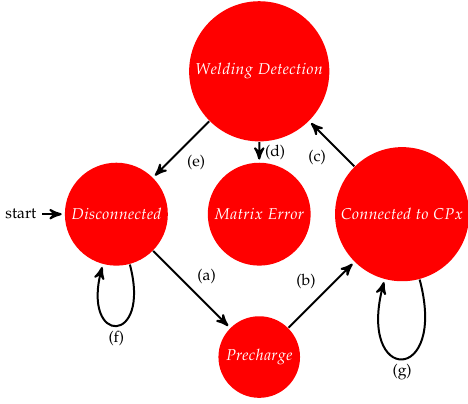
Figure 5. The Switching Matrix State Machine. (a) Relay Turn on Request, (b) Relay Turn on, (c) Relay Turn off Request, (d) Module Output Voltage not Decreasing, (e) Relay Turn off, (f) Relay Disabled and (g) Relay Enabled.